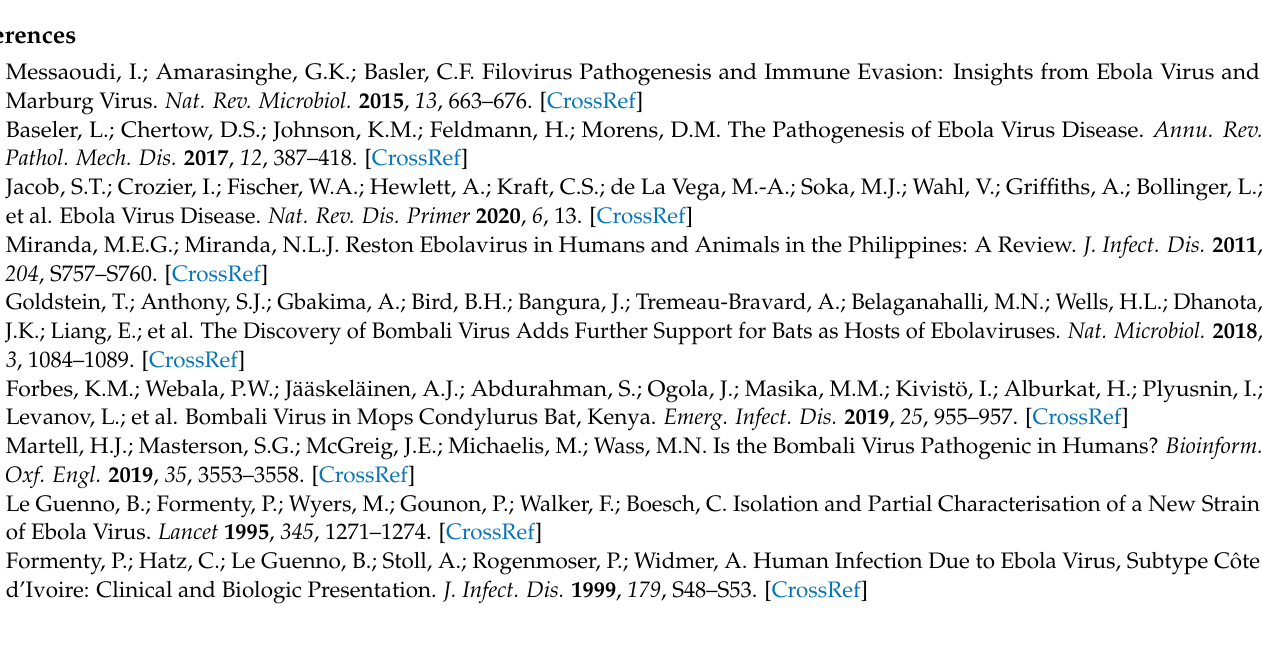
Table S2: Endpoint Titers of TAFV GP-specific